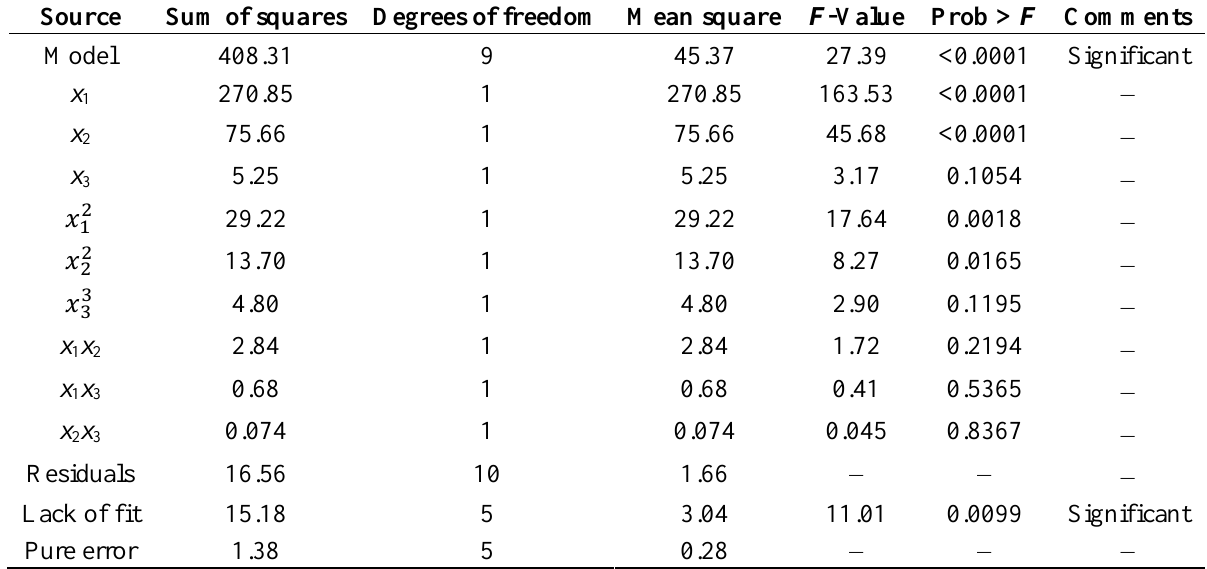
Table 2. ANOVA analysis and lack of fit test for the response surface model for the percentage of crystallinity ( y 1 ).